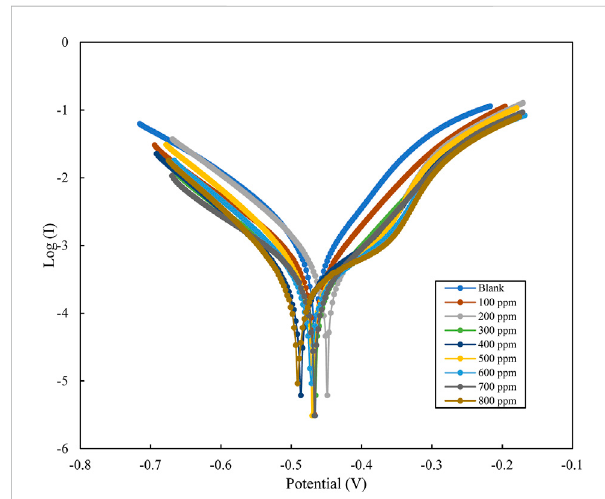
FIGURE 8 Potentiodynamic polarization plots for mild steel in 1M HCl with varying concentrations of polyacrylamide graft of okra